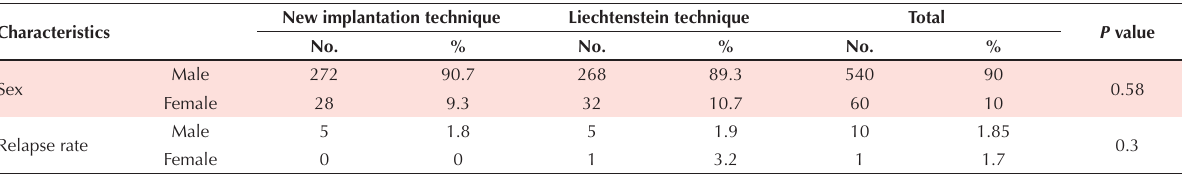
Table 1 . Frequency of gender and relapse rate in the two groups